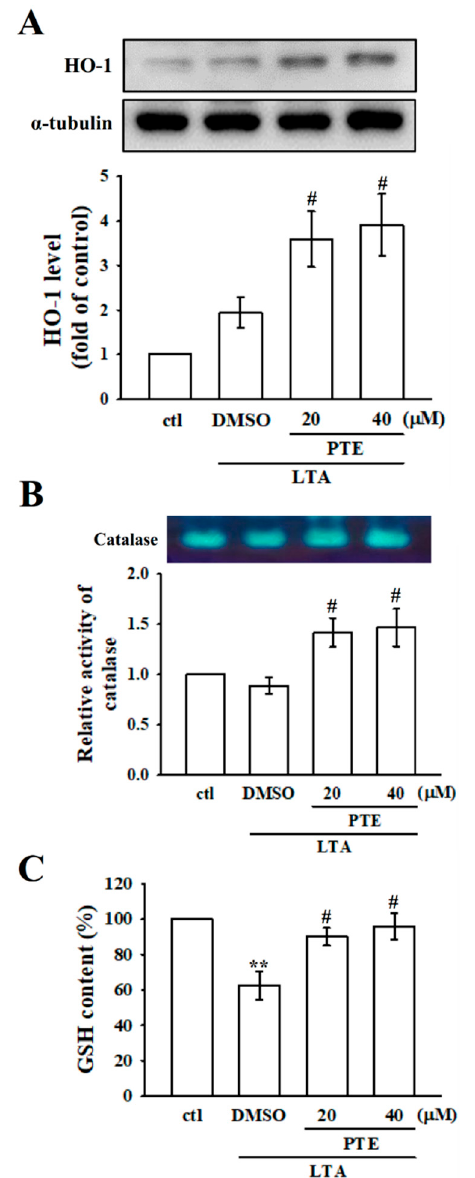
Figure 5. PTE enhances antioxidant defense molecules. Cells were treated with 0.1% DMSO or PTE (20 and 40 µM) for 30 min followed by LTA (5 µg/mL) for 24 h. PTE increases HO-1 expression ( A ), catalase (CAT) activity ( B ) and glutathione (GSH) content ( C ) in LTA-induced RAW cells. The figures are representative examples of three independent experiments. # p < 0.05 vs. LTA induced cells; ** p < 0.01 vs. control cells ( n = 4).